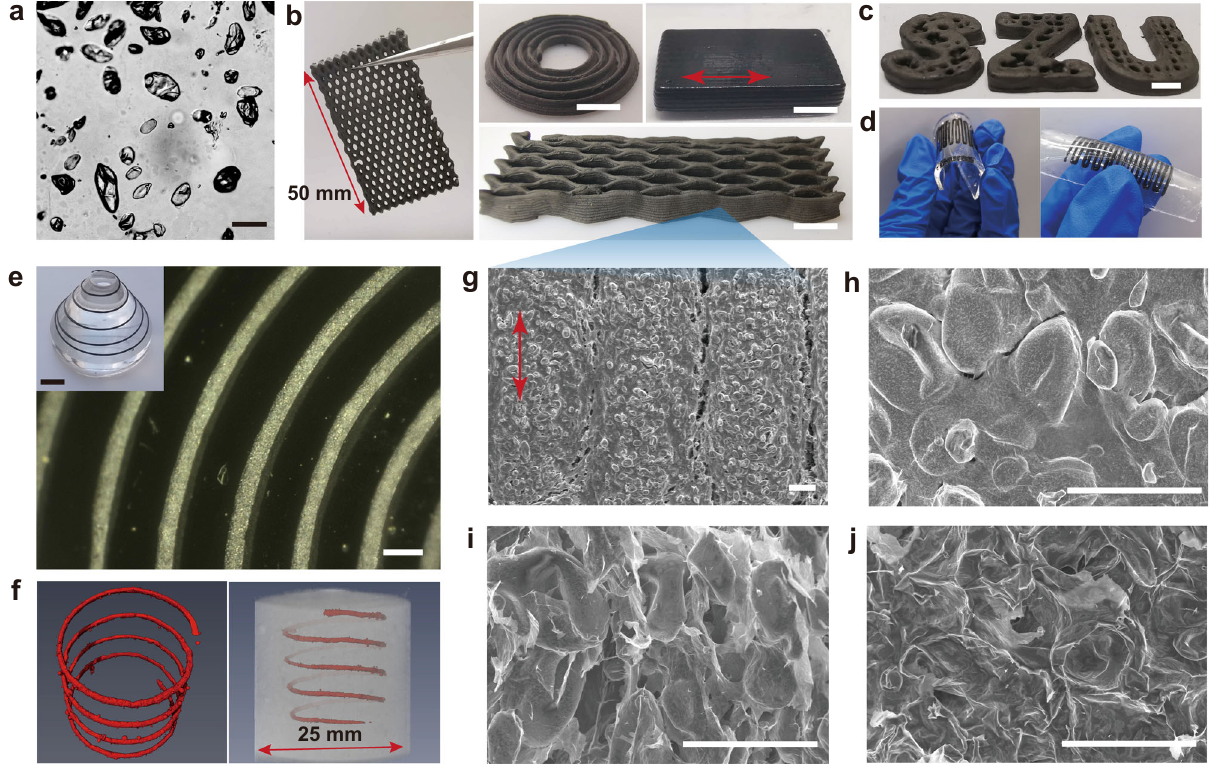
Fig. 4 3D printing of PW@NCs. a OM image of GO 1.0% /DDAB-PW emulsion droplets. b – d Optical images of various 3D-printed structures ( b , c ) and soft bent substrates with zigzag NCs embedded in d . e OM and optical images of the printed isometric spiral on the out-of-plane substrate. f Reconstructed 3D X-ray microcomputed tomography of the printed spiral in cement. g – i SEM surface ( g , h ) and cross-sectional images of PW@NC ( g ). j Cross-sectional SEM images of PW@NCs after annealing at 80 °C for 10 min. Scale bars, 100 μ m ( a ), 5 mm ( b , c , inset in e), 500 μ m ( e , g ), 50 μ m ( f – h